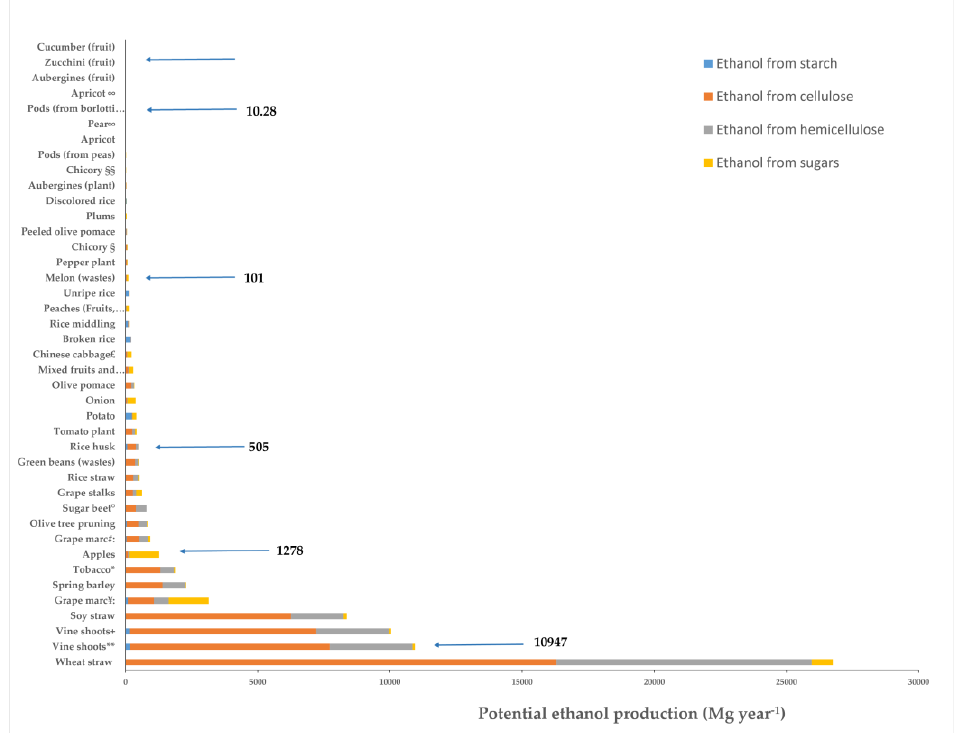
Figure 3. Yearly potential ethanol (Mg) obtainable from simple sugars, starch, cellulose, hemicellulose available in all analyzed residues. Arrows indicate the values of ethanol for selected byproducts. *: Nicotiana tabacum; **: cv Garganega; +: cv Valpolicella; ¥: nonfermented and containing stalks; ◦ : leaves and crowns; #: fermented; £: Brassica pekinensis; §: leaves and wastes; §§: water and leaves; ∞ : from processing